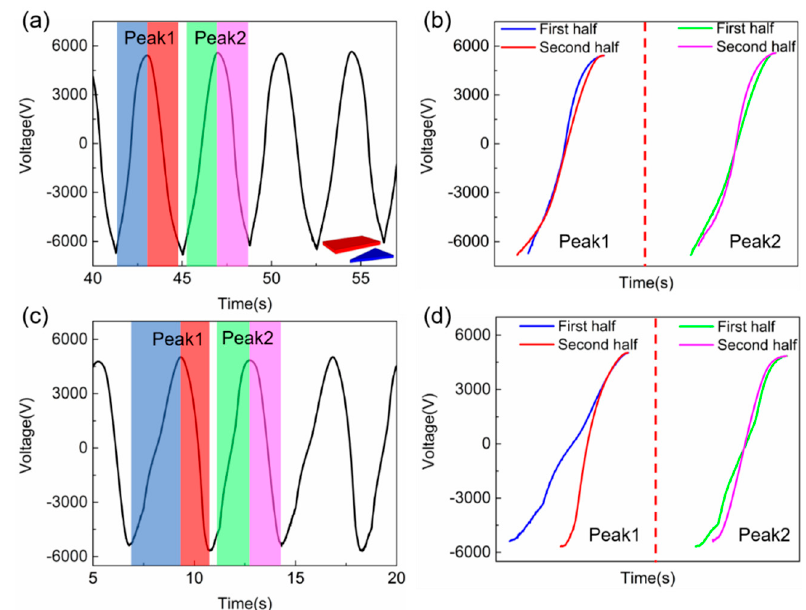
Figure 10. Voltage output of the triangular patterned TENG under an external load of ( a ) 10 12 and ( c ) 10 11 Ω . Voltage output of two different cycles under an external load of ( b ) 10 12 and ( d ) 10 11 Ω , demonstrating the voltage curve of triangular patterned TENG contains more information than that of rectangular patterned TENG, and the dynamic FEM model can be used to optimize the TENG tribo-material shape in sensing applications for multi-functional purposes.